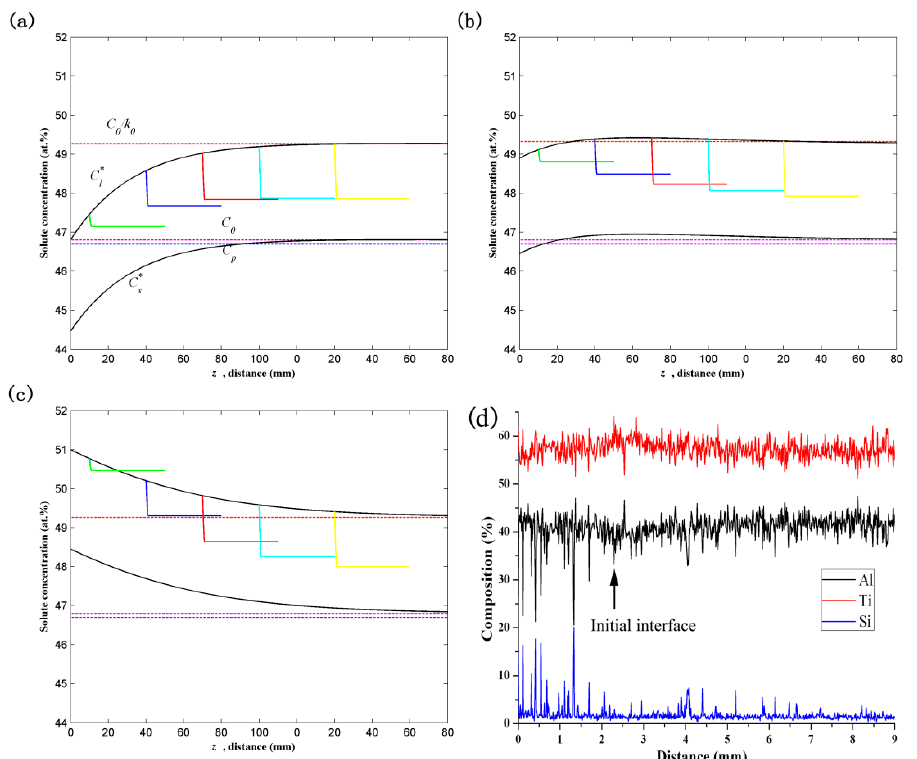
Figure 6. Solute distribution during the general seeding process when the initial concentration of the melt is 46.8% ( a ), 48.9% ( b ) and 51% ( c ) and the detected solute distribution of the solid phase at initial interface when the growth velocity is 10 μ m/s ( d ).